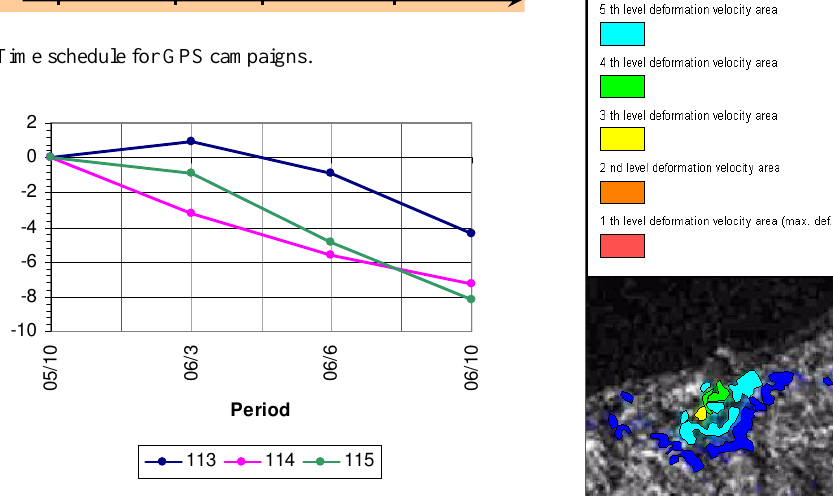
Figure 10. InSAR deformation map, digitized mine production map and Quickbird Orthoimage combined in GIS